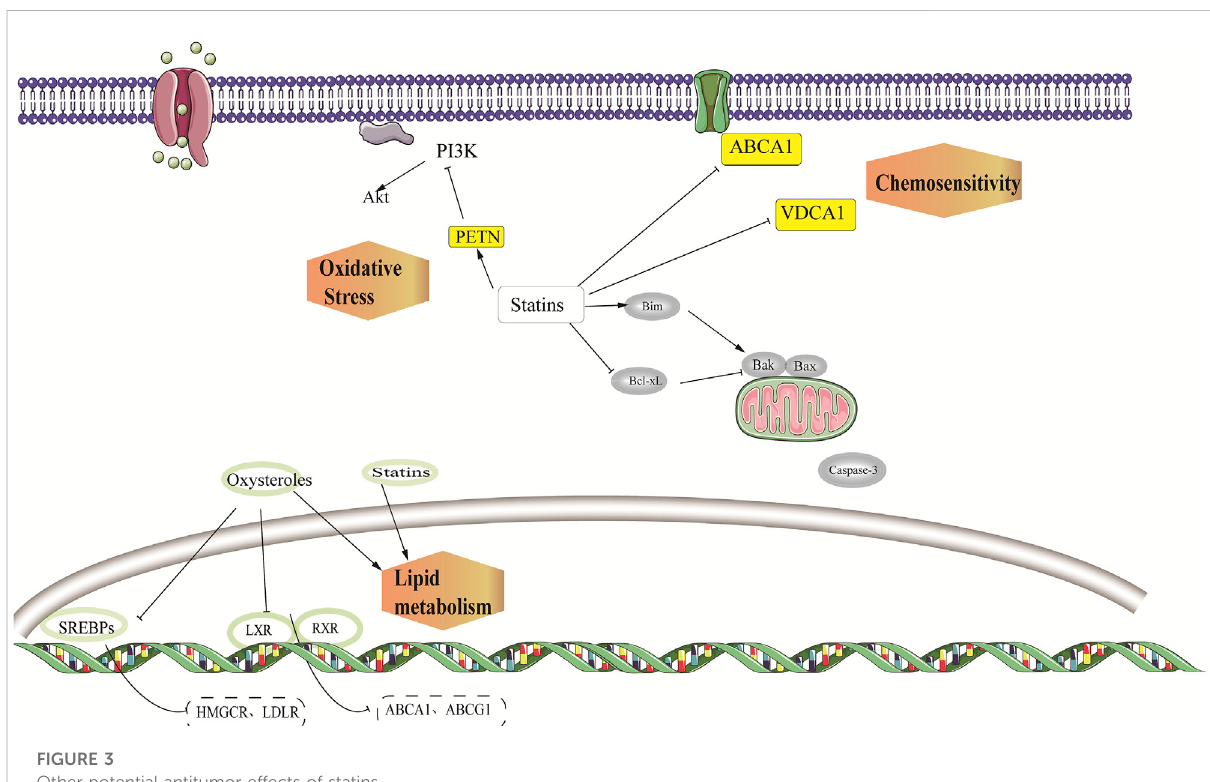
FIGURE 3 Other potential antitumor effects of